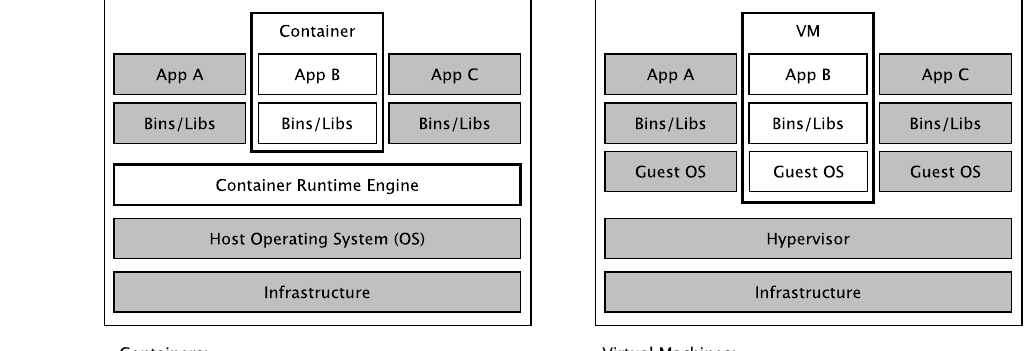
Figure 5. Comparing containers and virtual machines (adapted from the Docker